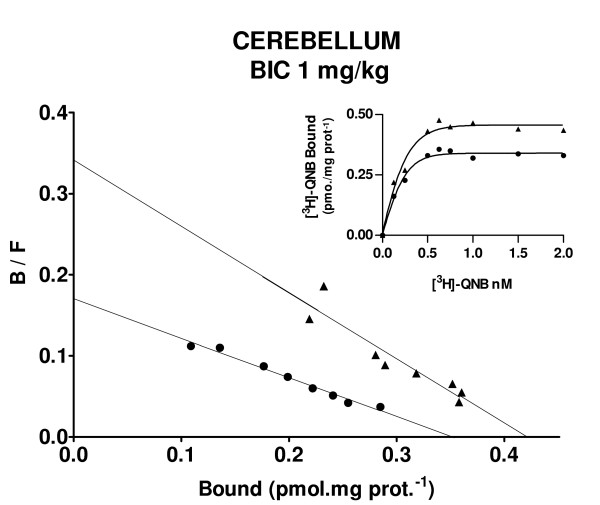
Scatchard plots for [3H]-QNB binding to rat cerebellar membranes at equilibrium after administration of a subconvulsant BIC dose (1.0 mg/kg). Results are from a single experiment representative of a set of three, each performed in duplicate. Inset, saturation curves. (●) Control; (▲) BIC subconvulsive.